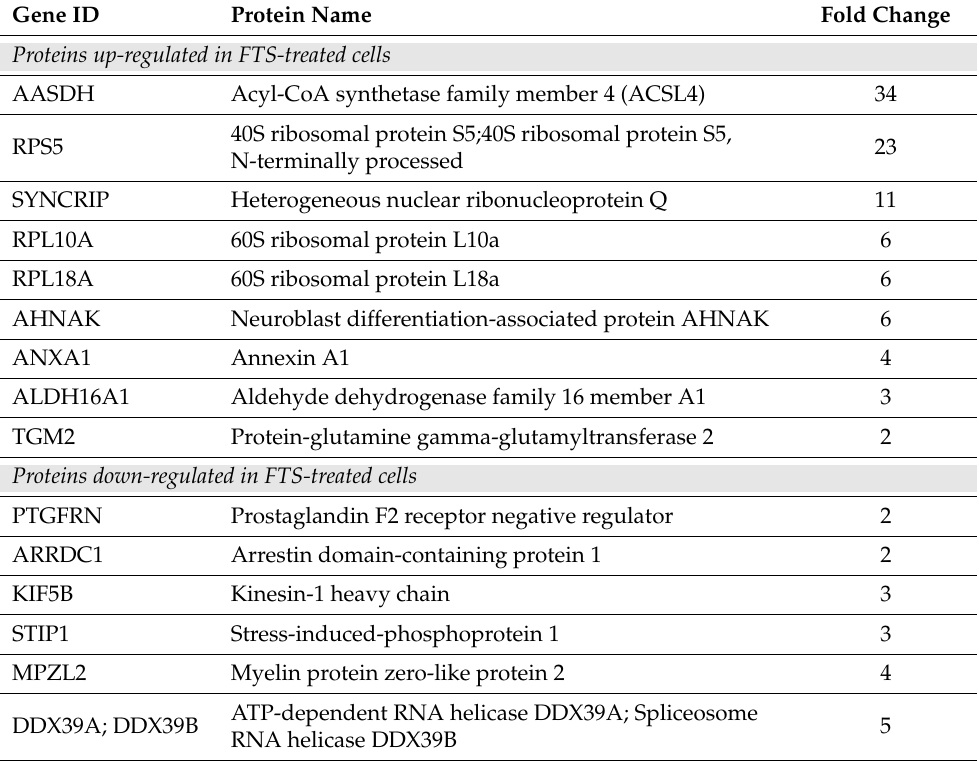
Table 4. Summary of the proteins differentially regulated in exosomes derived from FTS-treated SW480 cells when compared to untreated